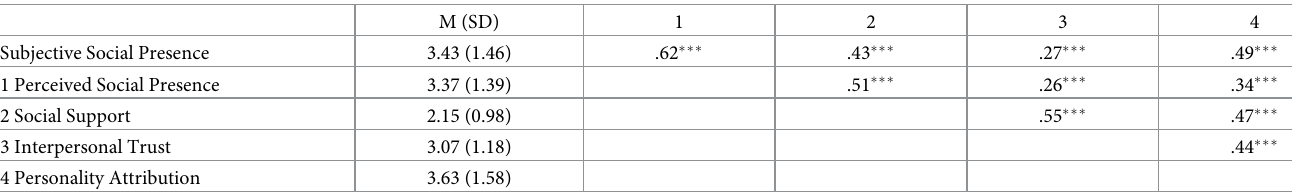
Table 1. Bivariate correlations, means and standard